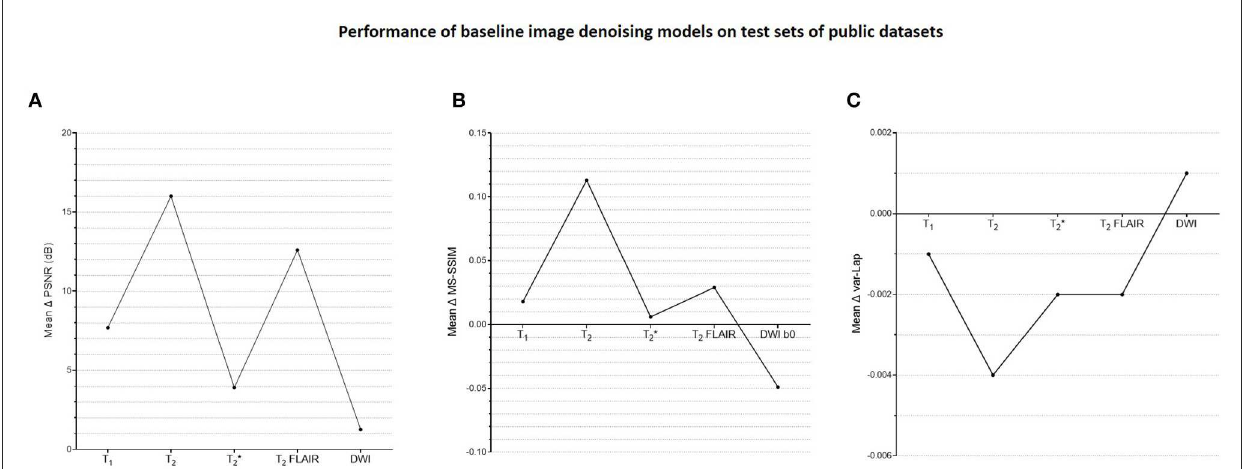
FIGURE5 Plots of quantitative evaluations of the contrast-specific baseline image denoising models on the test sets. The means of the changes in (A) PSNR (dB), (B) MS-SSIM, and (C) variances of the Laplacian (var-Lap) values are reported. Lowest validation loss models were used in all instances. Higher PSNR and MS-SSIM indicate larger improvements in the image quality of the denoised images. Higher var-Lap values indicate lower loss of sharpness of the denoised images.